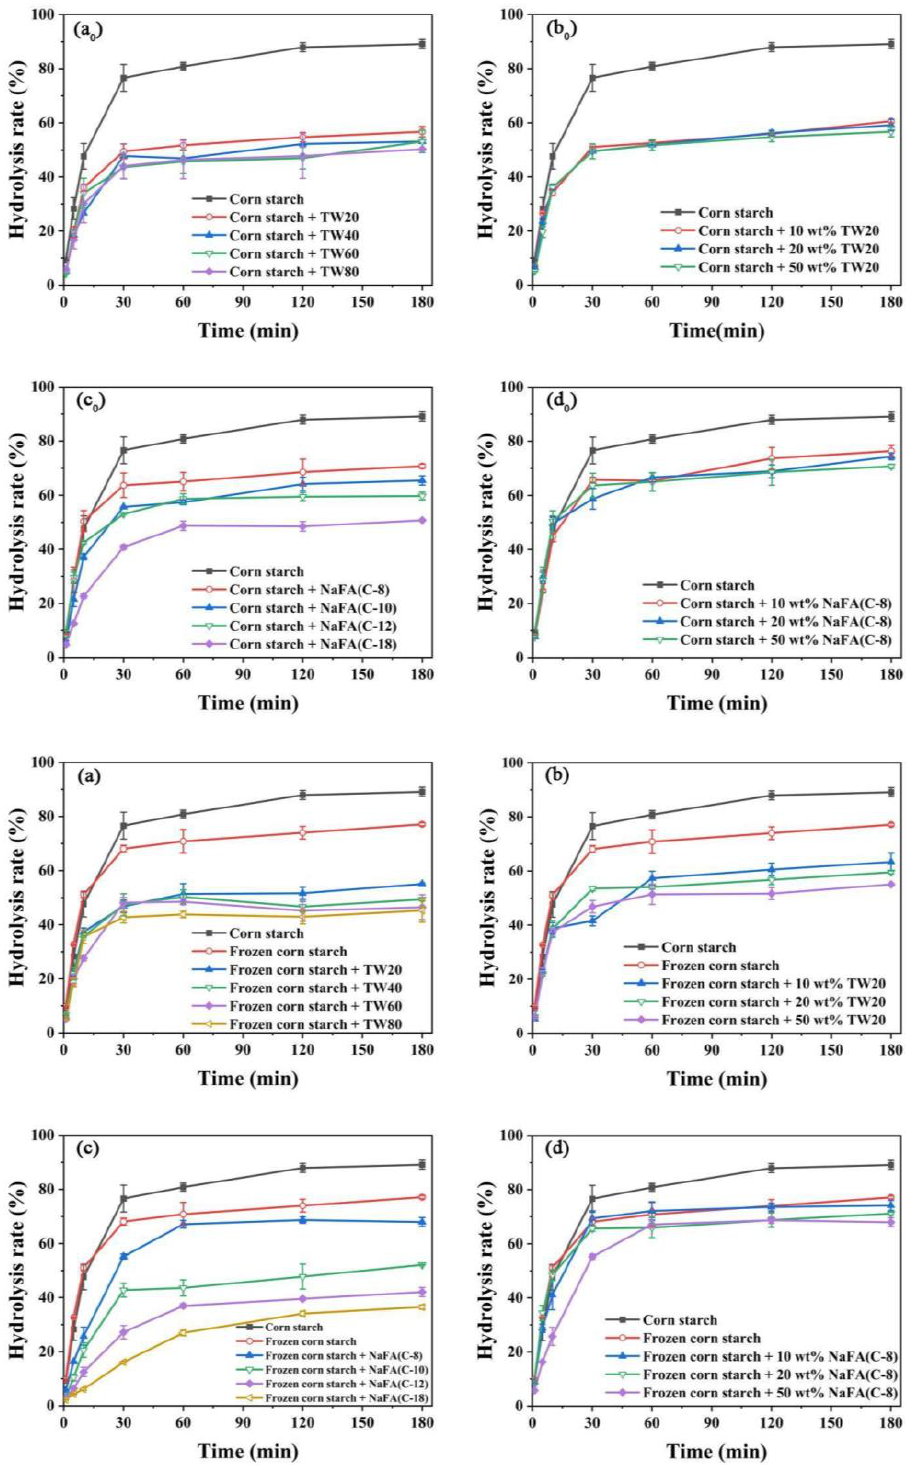
Figure 6. Digestibility of regular ( a 0 – d 0 ) or frozen ( a – d ) corn starch in the presence of Tween (TW) and sodium fatty acid (NaFA). ( a 0 , a ) The effect of carbon chain length of TW on starch digestibility (50 wt%). ( b 0 , b ) The effect of concentrations of TW20 on starch digestibility. ( c 0 , c ) The effect of carbon chain length of NaFA on starch digestibility (50 wt%). ( d 0 , d ) The effect of NaFA (C-8) concentration on starch